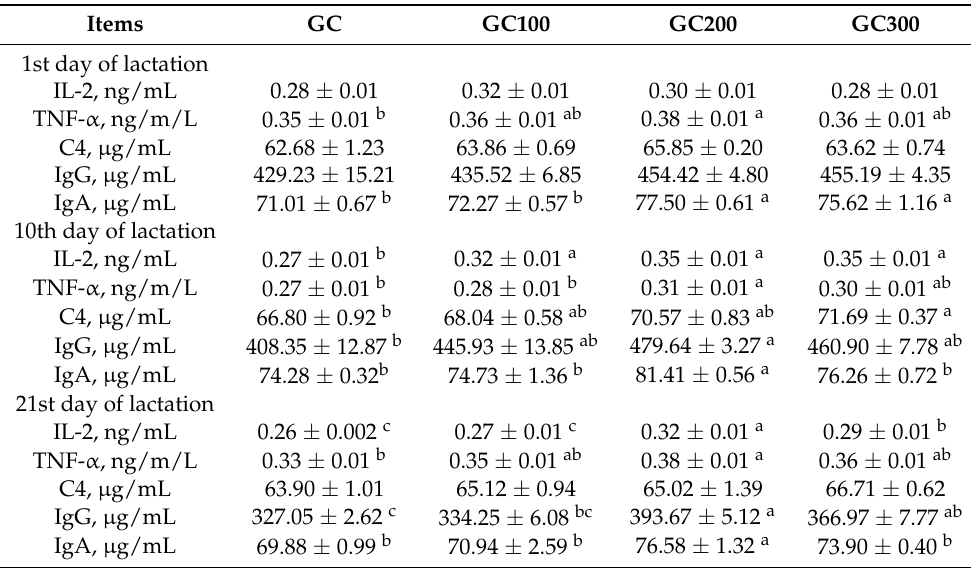
Table 5. Effects of SI and APS mixture on serum immune indexes of lactating